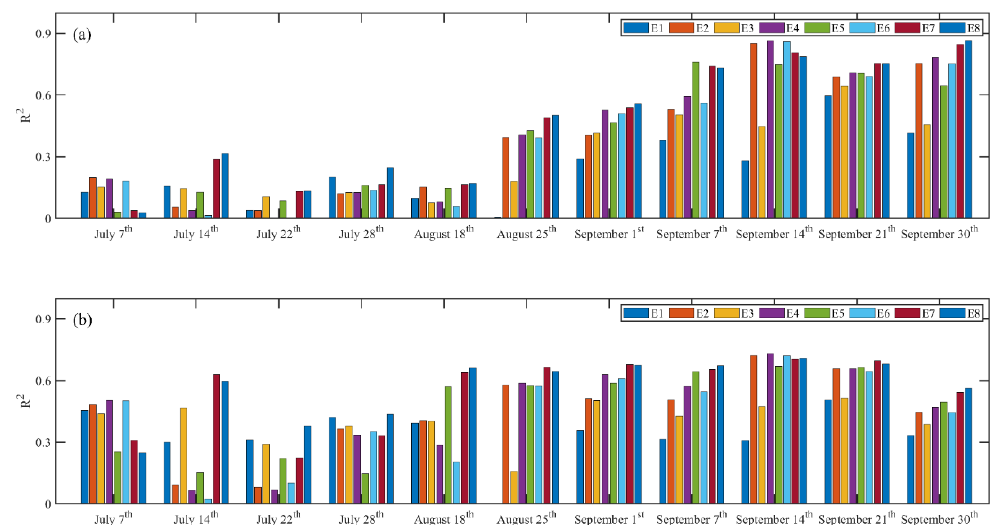
Figure 4. The R 2 between VI, chlorophyll contents, and yields of maize during the whole growth stages. Note: E is short for equation according to Table 2, and E8 is the MRBVI. ( a ) The R 2 between VI and chlorophyll contents increased gradually from August 25 ( b ) R 2 between VI and yield increased